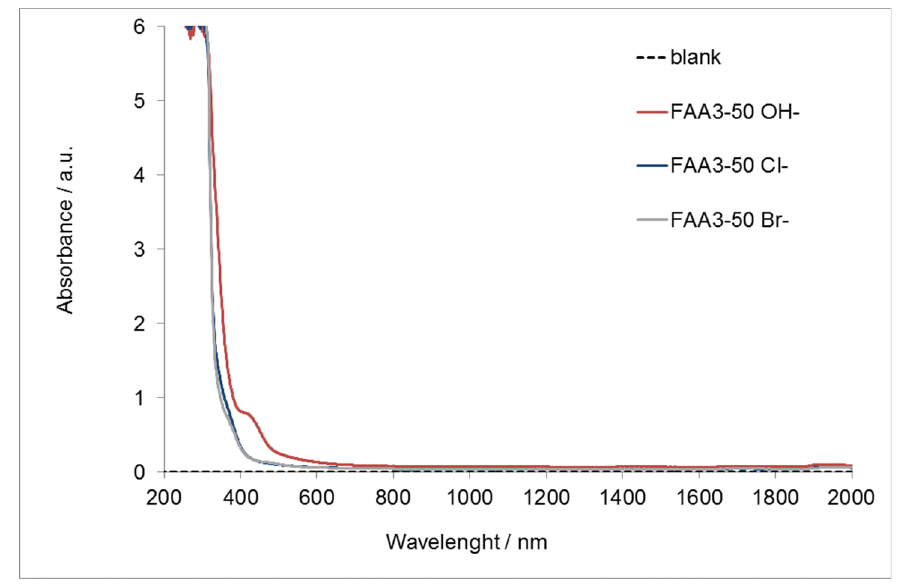
Figure 3. UV-Vis–NIR absorption for FAA3-50 in chloride, bromide, or hydroxide form.